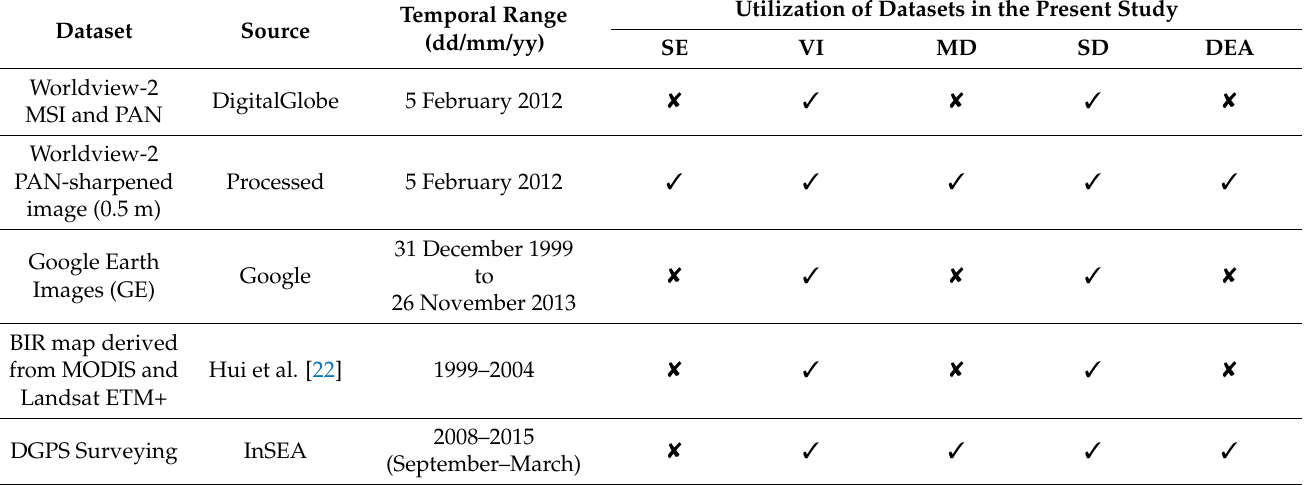
Table 1. Satellite and ground reference datasets and their specific usage in this study. A variety of spatial datasets (both satellite data and ground reference data) were utilized at different stages of the study. The potential usage of these datasets includes: (1) SE (semi-automatic feature extraction): The datasets are used as input for semi-automatic extraction methods; (2) VI (visual interpretation): The datasets are used for visual interpretation to support digitization, to interpret BIRs, and to ensure spatial snow/ice cover changes are captured; (3) MD (manual digitization): The datasets are used in an ArcGIS platform to carry out digitization; (4) SD (supplementing digitization): The datasets are used to cross-check and verify the manual digitization against various ground reference and satellite images; and (5) DEA (digitization error analysis). The datasets are used to test positional errors in manual digitization. The notation (cid:51) ( (cid:56) ) denotes used (not used) in this